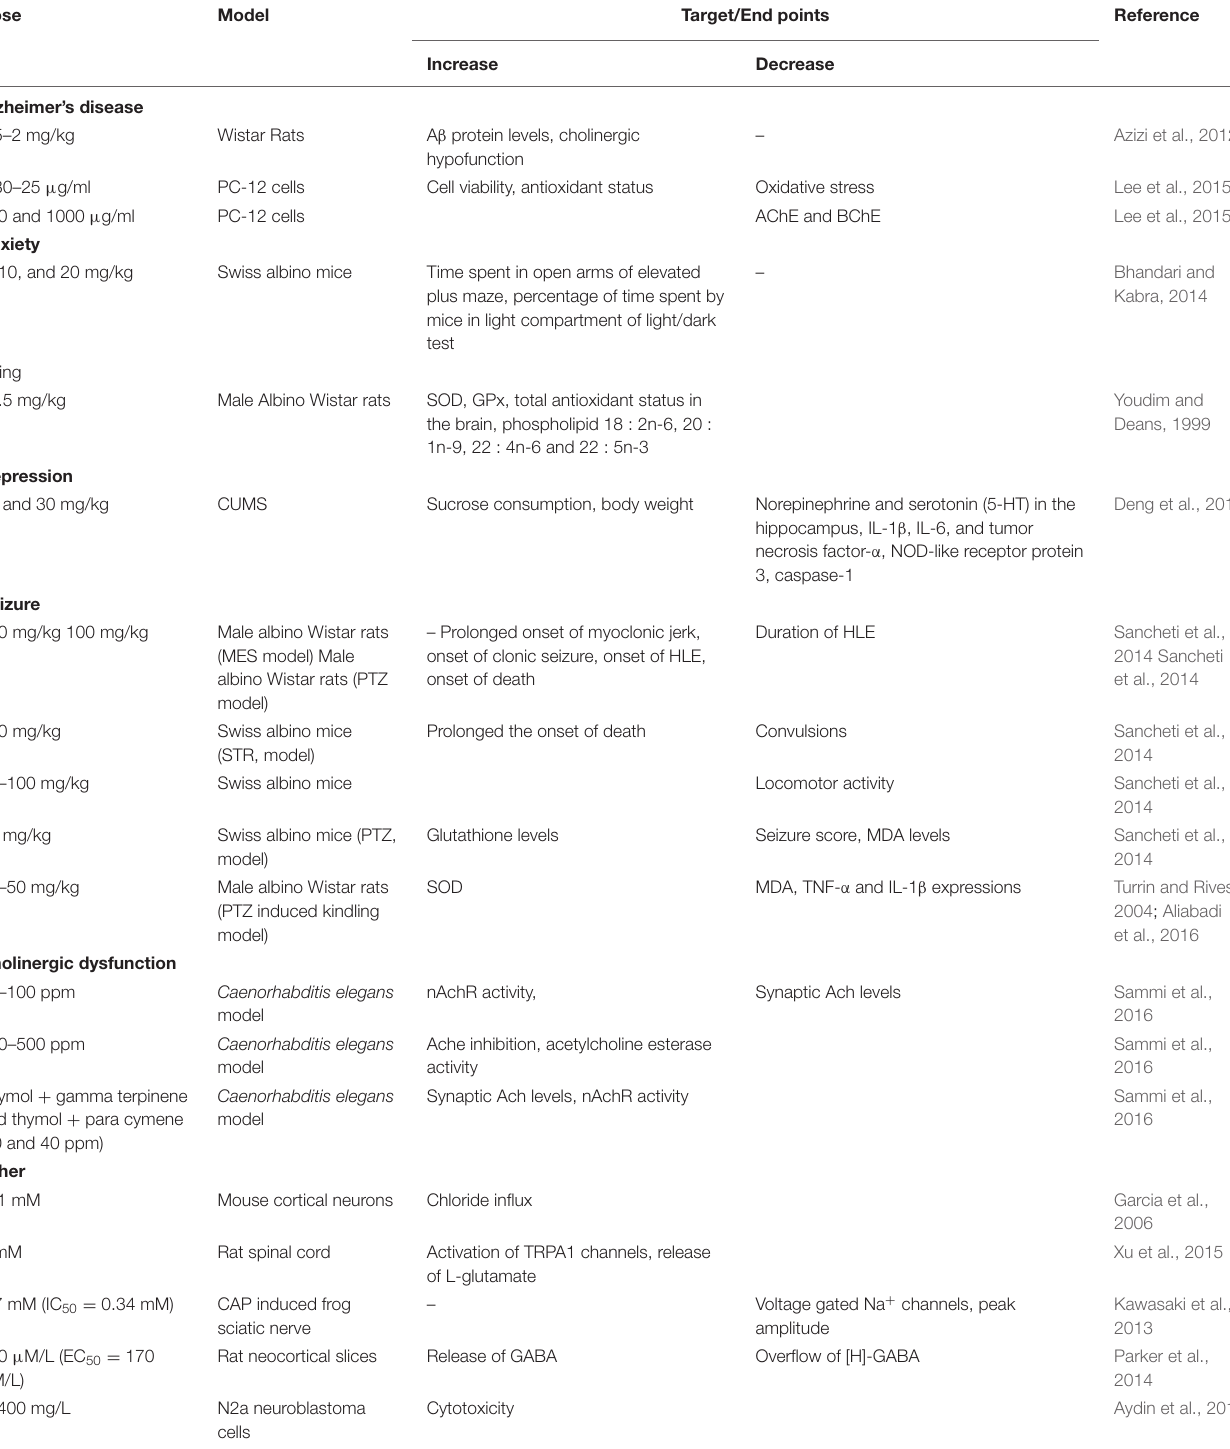
TABLE 5 | Effect of thymol in different experimental models of neurogenerative